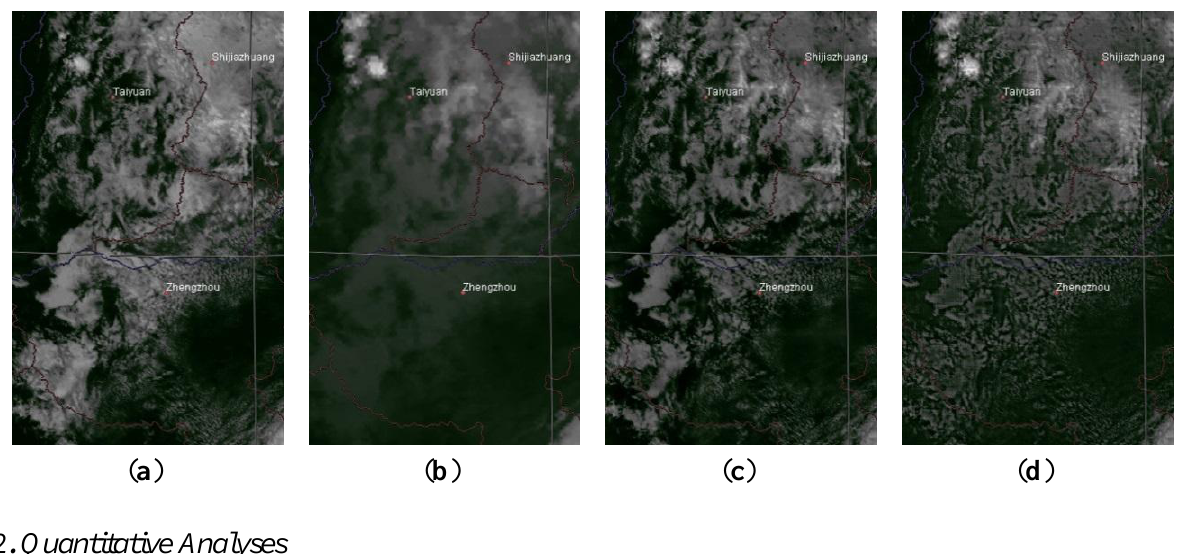
Figure 6. MTSAT image of the borders of Hebei, Shanxi and Henan Provinces of